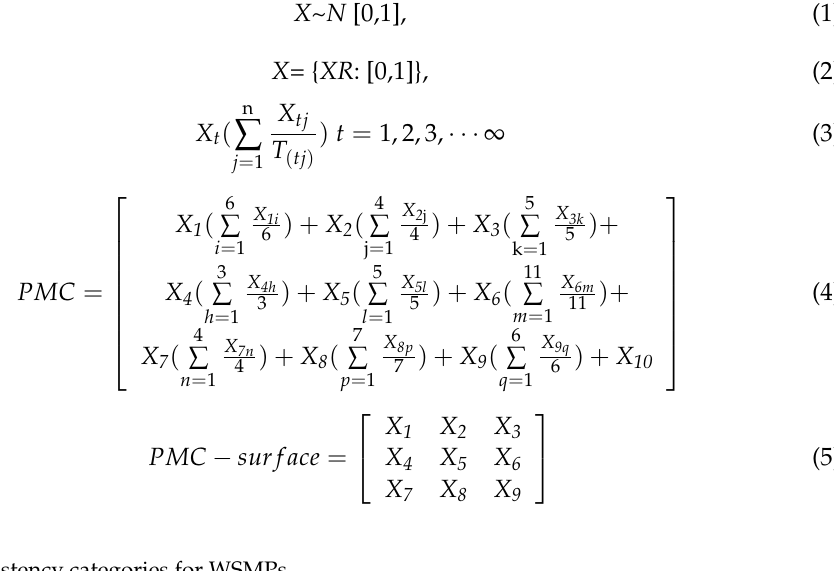
Table 3. Consistency categories for